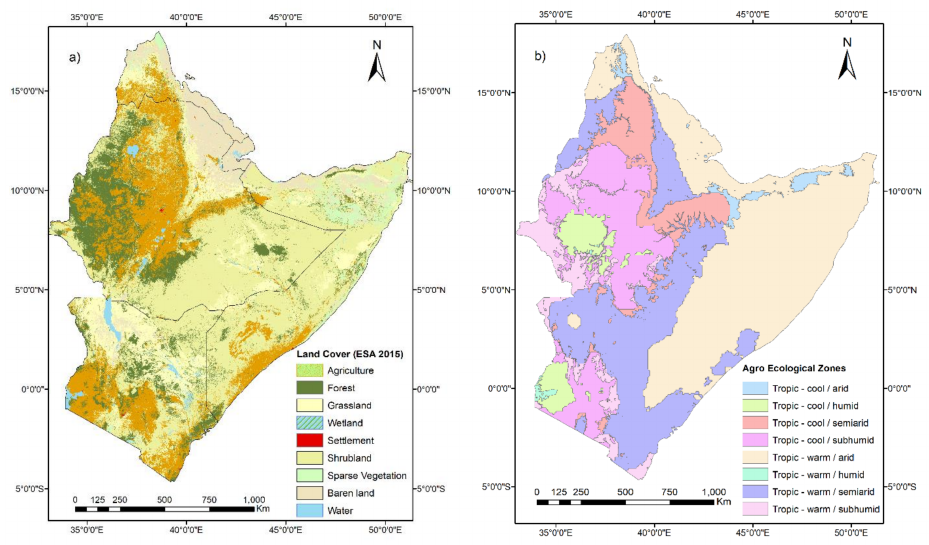
Figure 2. Land cover types ( a ) and agroecological zones ( b ) in the Horn of Africa. Data source: ESA land cover 2015, and RCMRD GeoPortal for the Agroecological